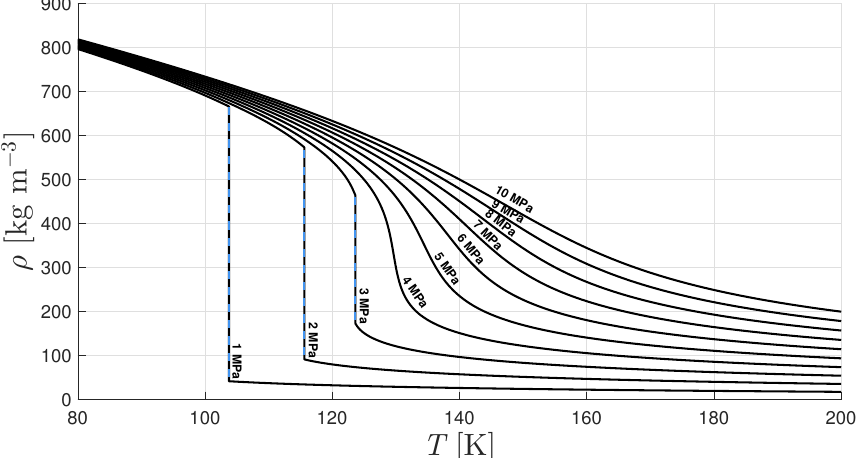
Figure 2. Variation of nitrogen’s density for a temperature range of 80 to 200 K, extracted from